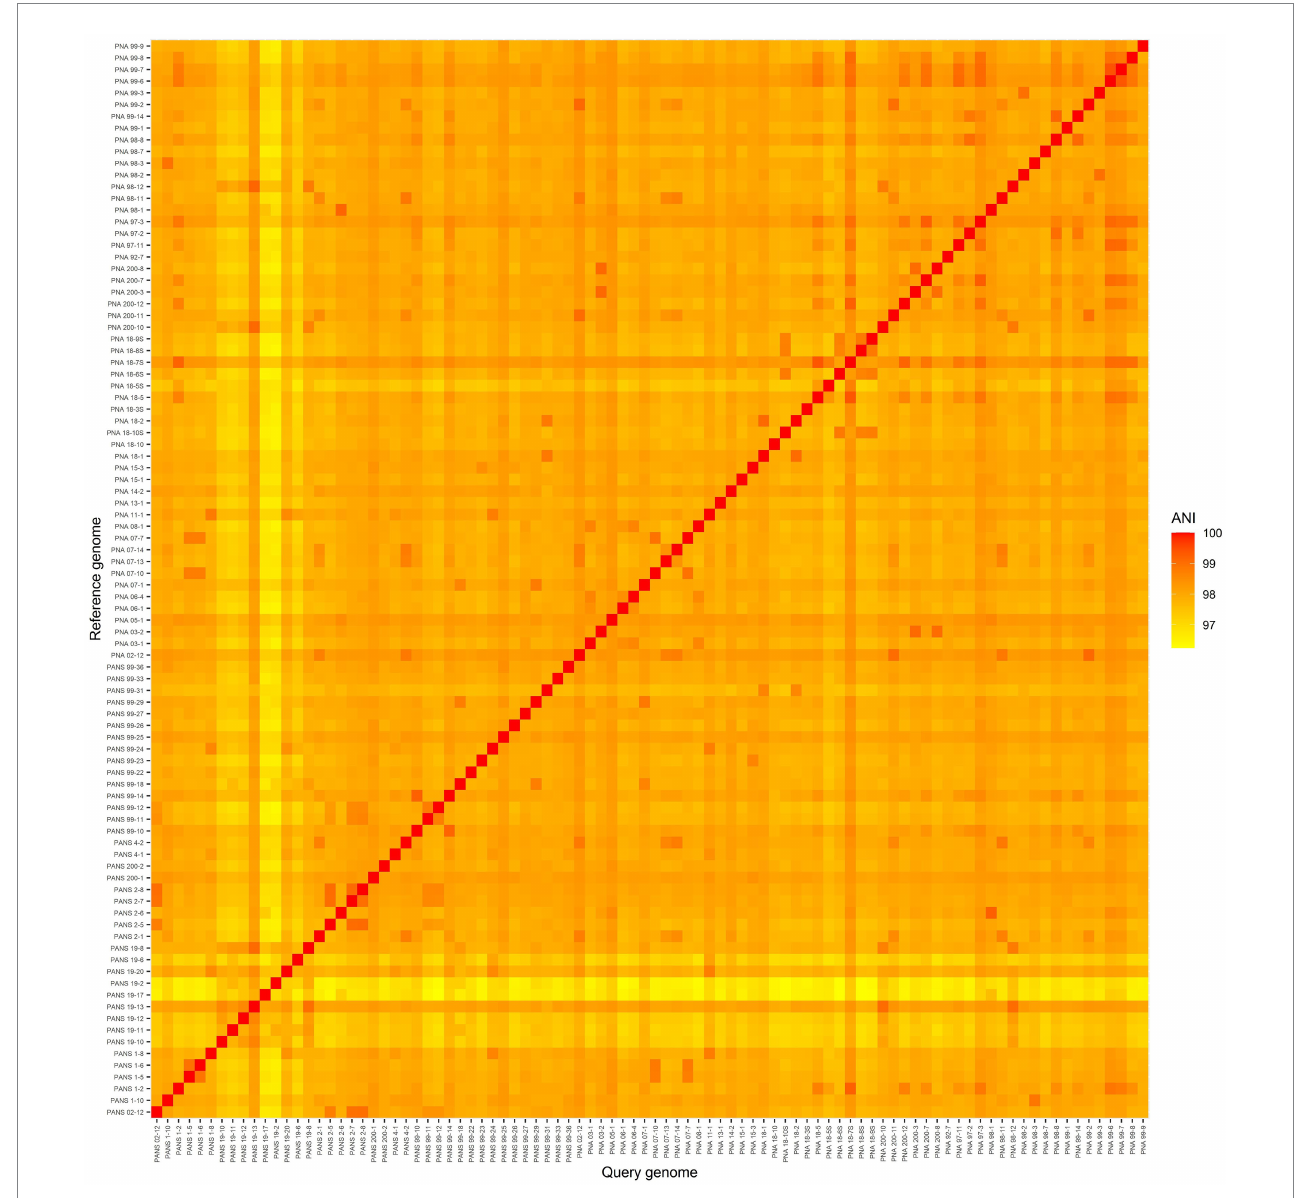
FIGURE 2 A heatmap of average nucleotide identity (ANI) comparisons of 92 Pantoea ananatis genomes. The smallest ANI comparison was between PNA 18-6S and PANS 19-17 with an ANI score of 96.25. The highest ANI comparison non-self-strain comparison was between PNA 99-6 and PNA 99-7 with a score of